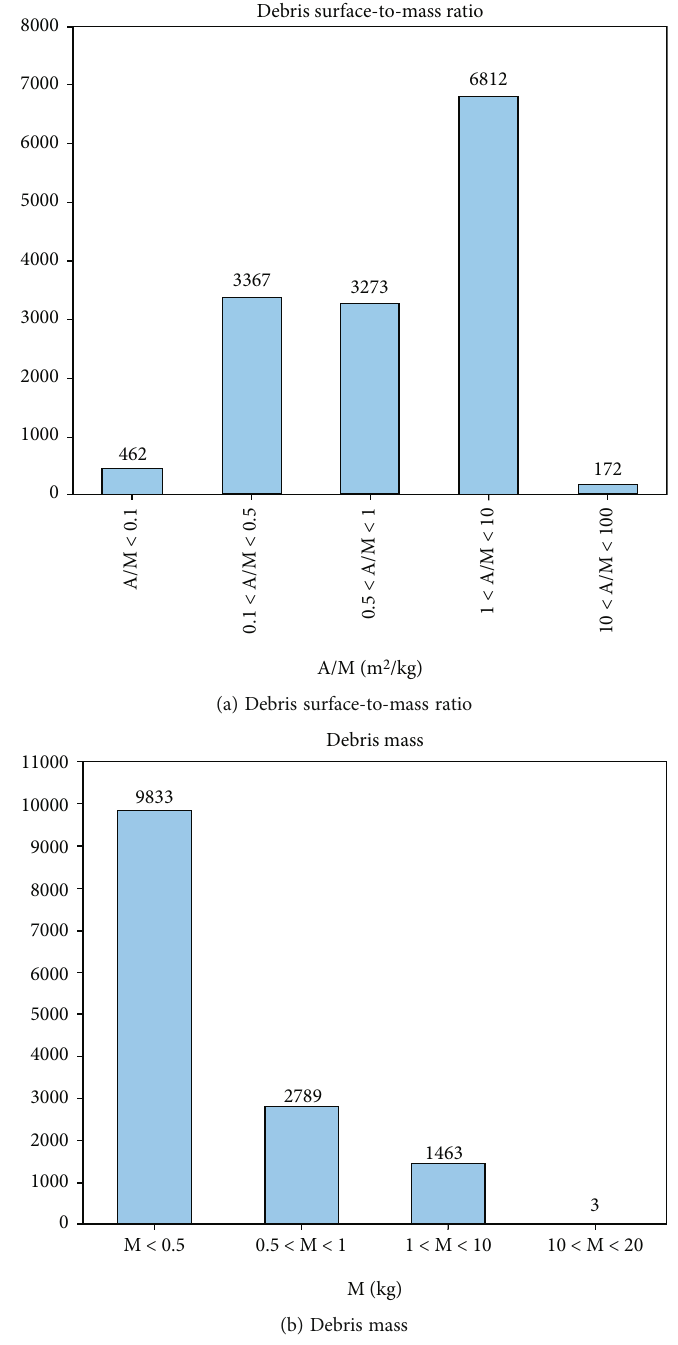
Figure 15: Fragment surface-to-mass ratio and fragment